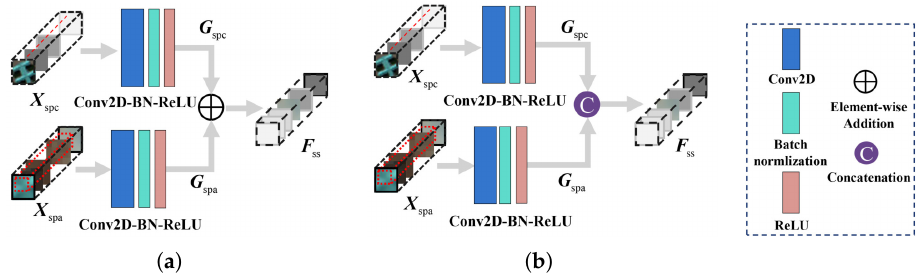
Figure 3. Basic fusion models with ( a ) element-wise addition and ( b ) feature